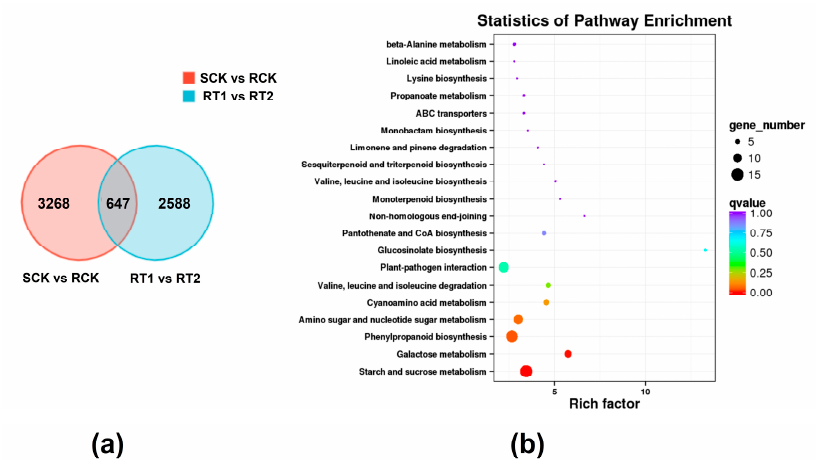
Figure 4. Screening for potential fenoxaprop-P-ethyl metabolic genes: ( a ) Venn interaction of different groups; ( b ) KEGG enrichment pathways of 647 genes. Table 1. Potential fenoxaprop-P-ethyl metabolic genes in rice.